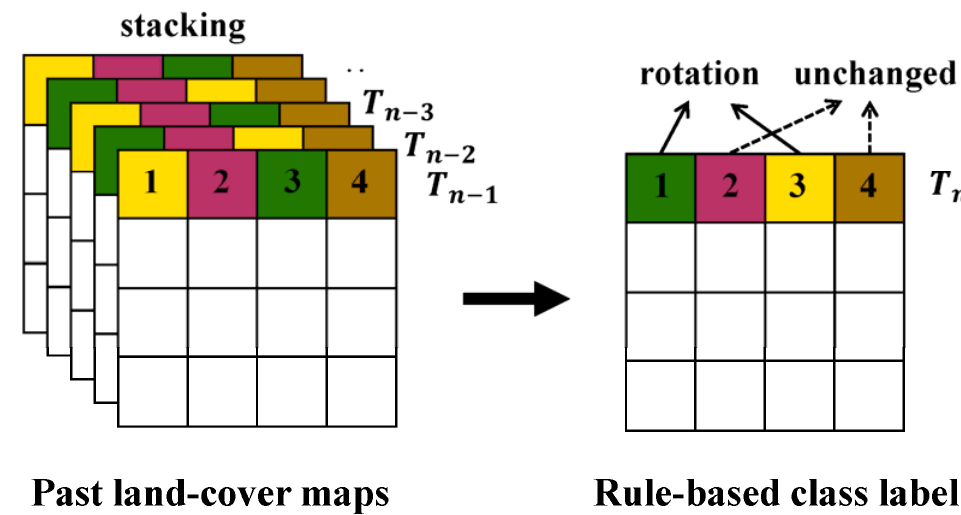
Figure 3. Illustrations for the process of generating rule-based class labels. Past land-cover maps are stacked and compared, where T n is the reference year under consideration.